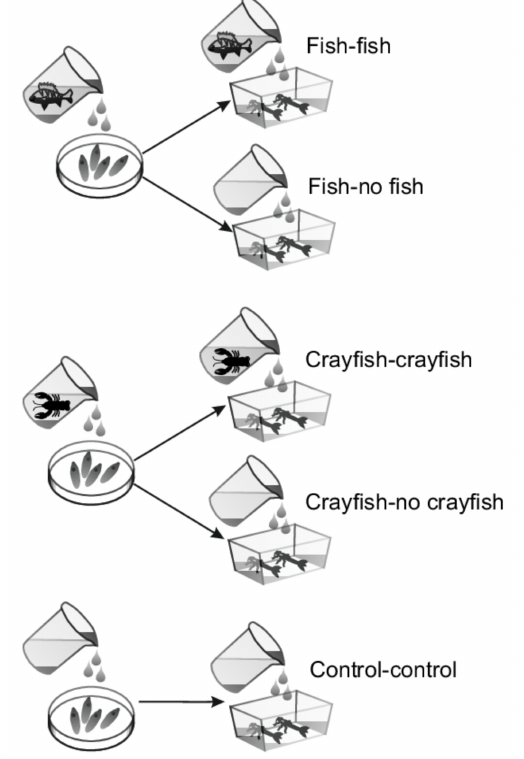
Figure 1. Experimental design. Initially, I. elegans eggs were assigned to groups receiving perch cues, crayfish cues or no predator cues. At hatching, the perch cues egg group was divided into perch-cues and no-perch-cues larval groups, and the crayfish cues egg group was divided into crayfish cues and no crayfish cues larval groups. The control group experienced no perch or crayfish cues in either the egg or larval